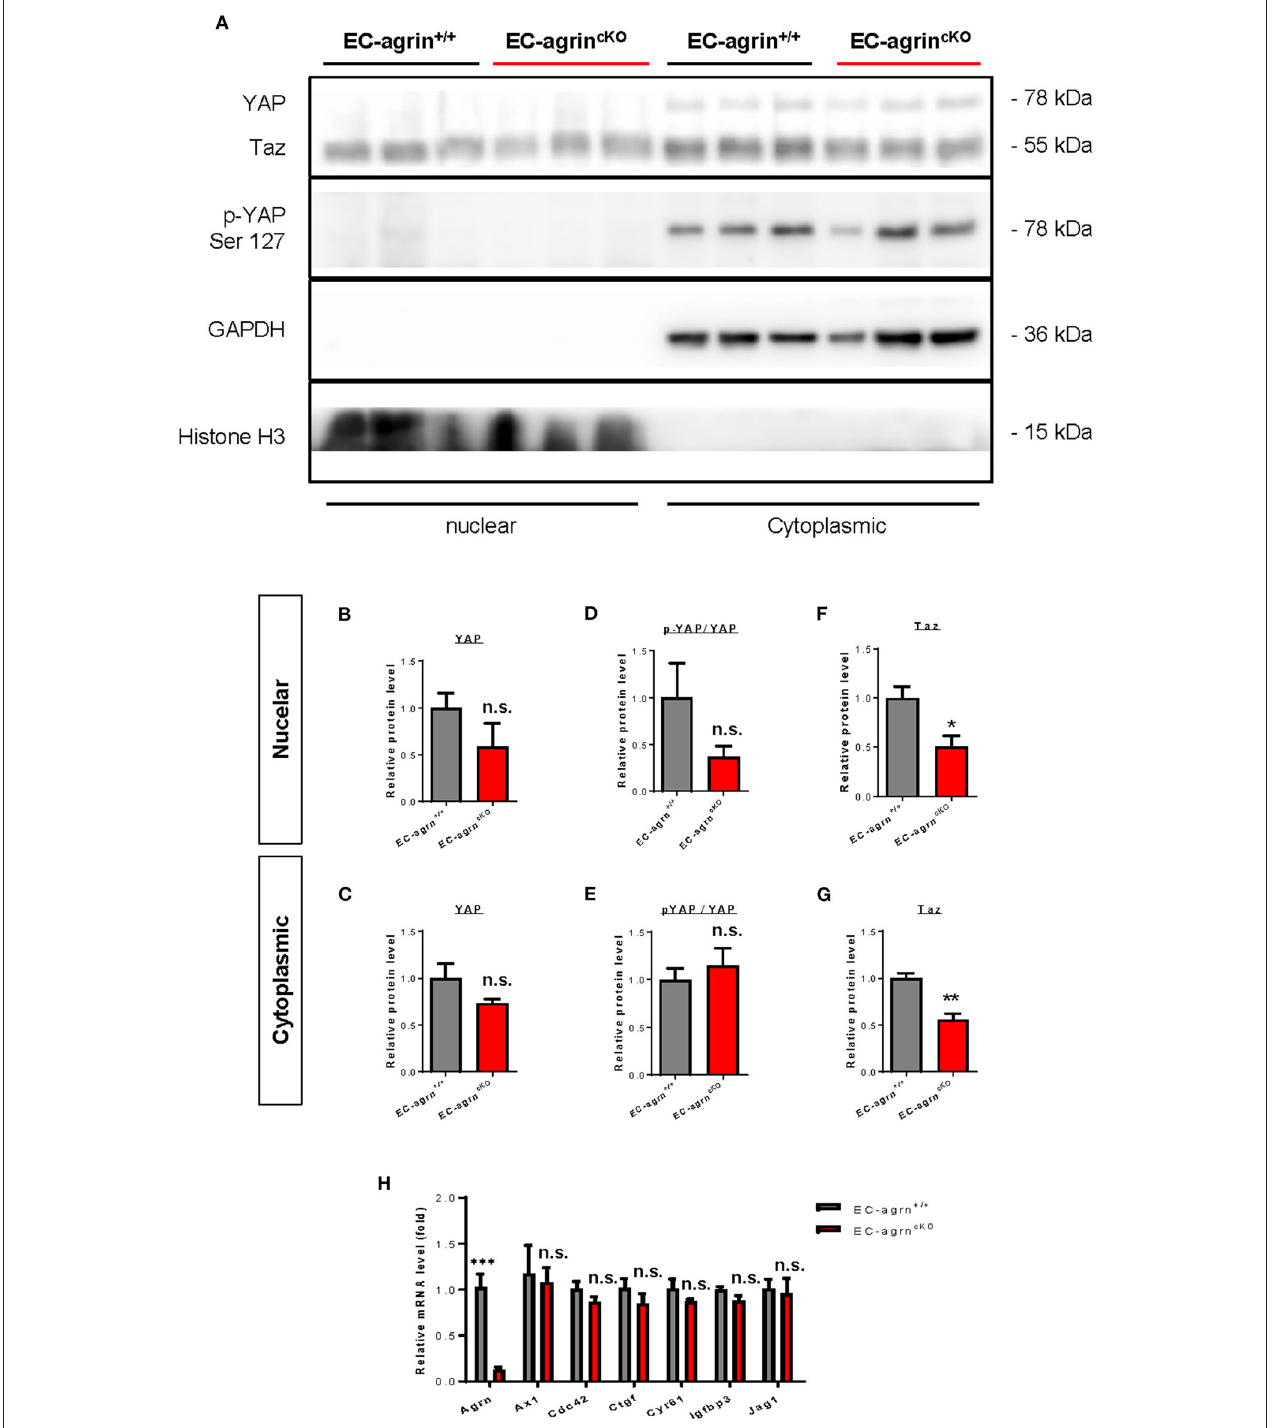
FIGURE 6 | Agrin does not regulate endothelial YAP mediated activation in vivo. (A) Western blotting analysis showing no significant difference in the nuclear or cytoplasmic distributions of Yap but significantly reduced Taz after endothelial loss of agrin in vivo . The nuclear and cytoplasmic (B,C) expression and (D,E) activation levels of YAP; as well as the (F) nuclear and (G) cytoplasmic expression levels of Taz were measured in the skeletal muscle ECs of 6–8 weeks old EC-agrn + / + and EC-agrn cKO mice, respectively. (H) RT-qPCR analysis showing no significant difference in expression levels of YAP target genes after endothelial loss of agrin. (B–H) Data are presented as mean ± S.E.M., n = 3-6, differences were determined by ANOVA and Turkey’s HSD post-hoc test, * P < 0.05, ** P < 0.01, *** P < 0.001, n.s. denotes no significant difference.